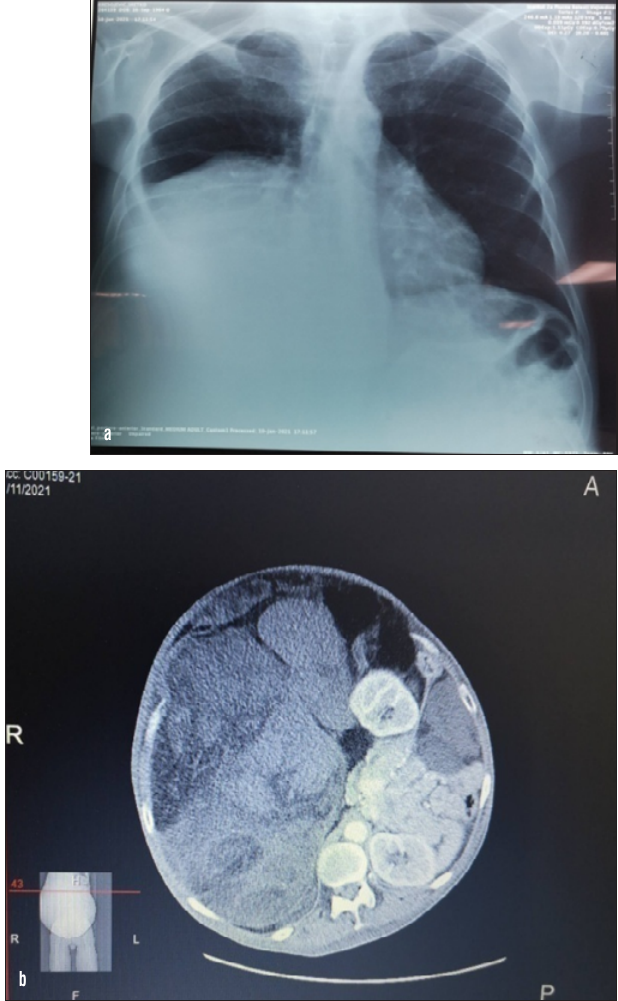
Figure 2. Preoperative chest X-ray showing right diaphragmatic elevation due to the tumor size (a) and preoperative computed tomography (CT) scan of the abdomen showing a giant solid mass (b)